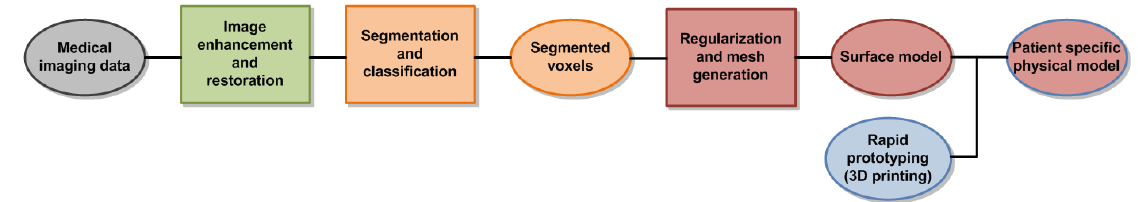
Figure 1. Patient-specific 3D modelling and rapid prototyping